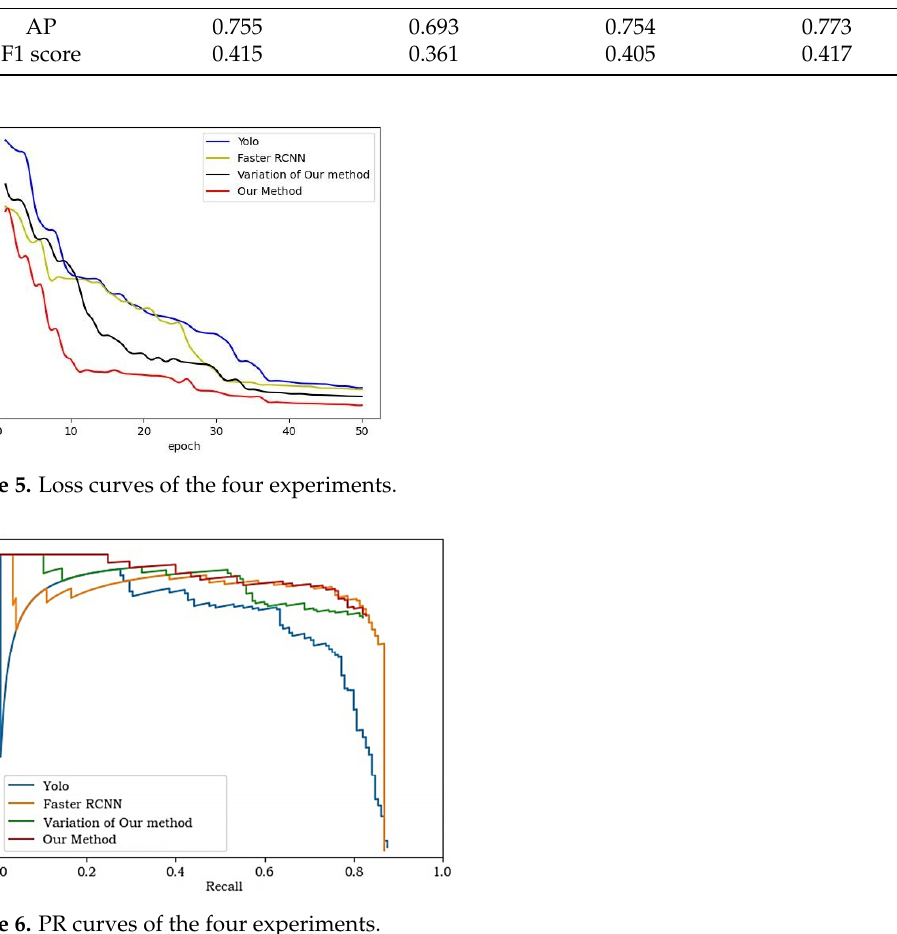
Figure 6. PR curves of the four experiments.